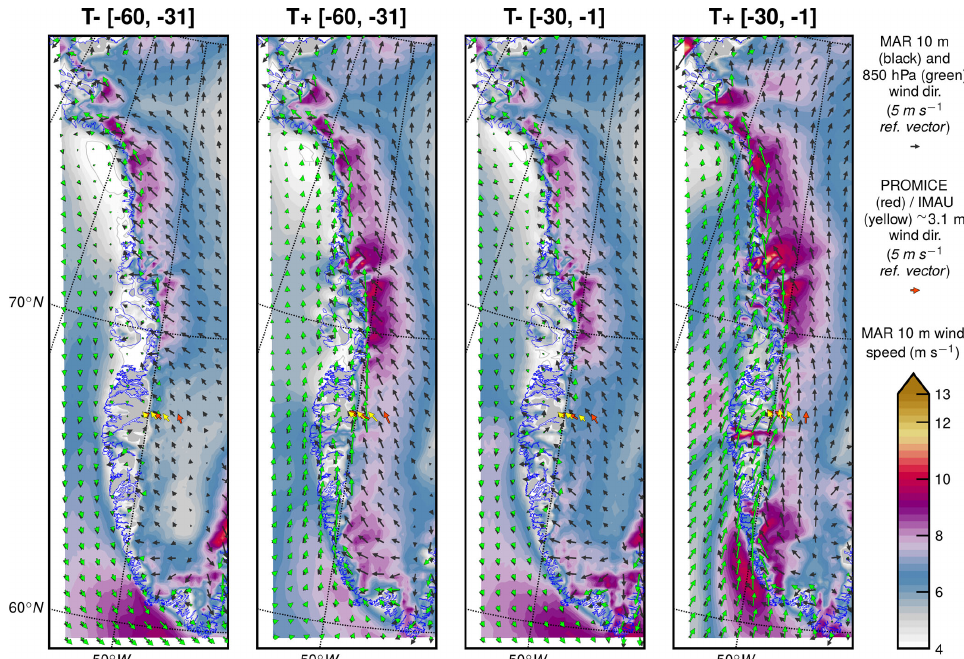
Figure 7. Composites of MAR 10m (black arrows) and 850hPa (green arrows) vector winds for the T + and T − events at KAN_B preceding the Baffin Bay date of sea ice advance (DOA), 2011–2015. Wind observations from PROMICE (red) and IMAU (yellow arrows) are overlaid for reference.